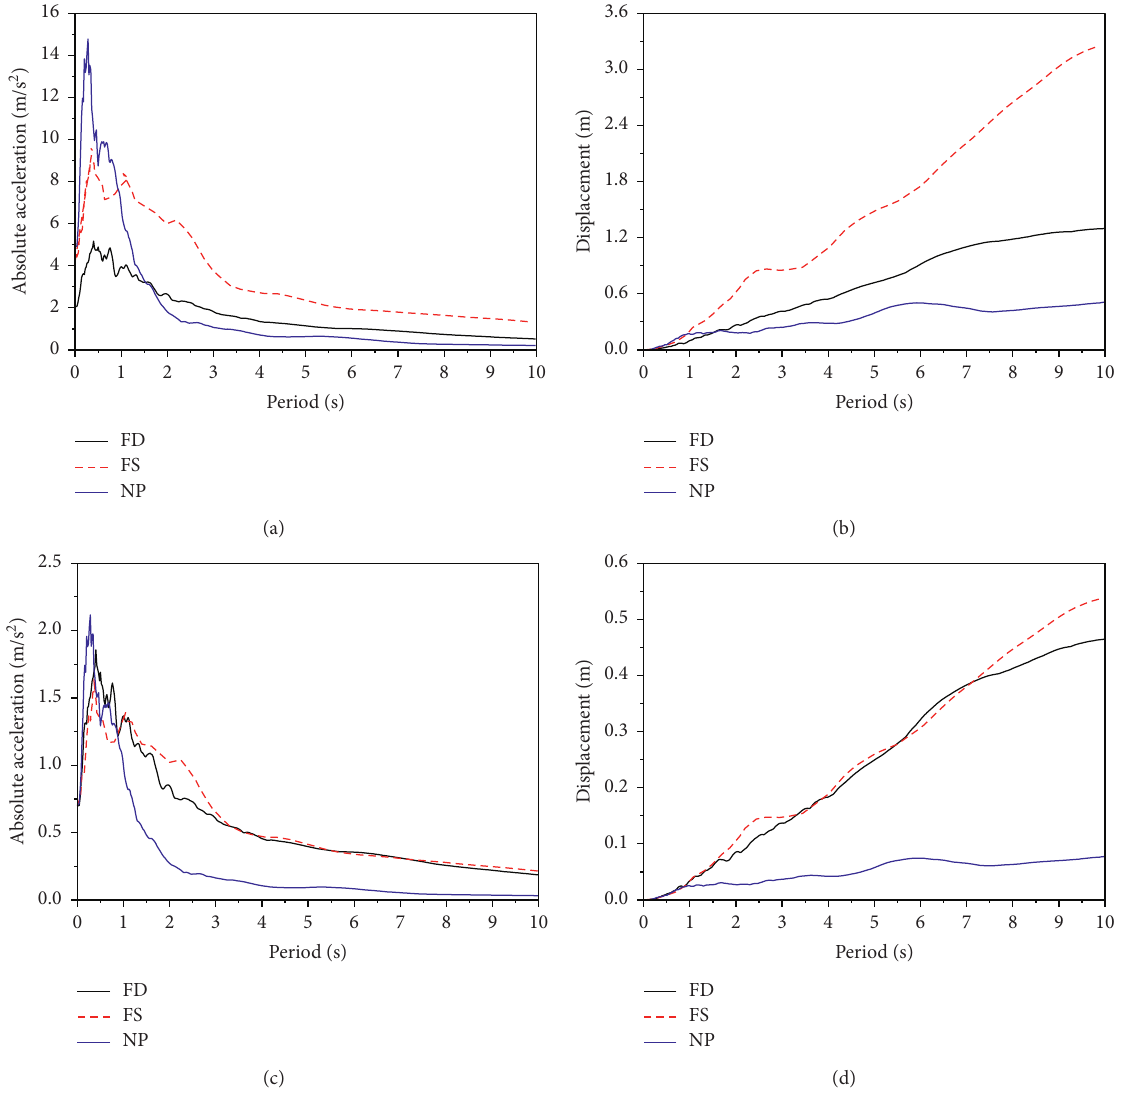
Figure 11: The response spectra of ground motions with forward-directional velocity pulse, fling-step velocity pulse, and nonspeed pulse: (a) the acceleration spectra without amplitude modulation; (b) the displacement spectra without amplitude modulation; (c) the acceleration spectra with amplitude modulation; (d) the displacement spectra with amplitude modulation. Note . FD is the forward-directivity velocity pulse; FS is the fling-step velocity pulse; NP is nonspeed